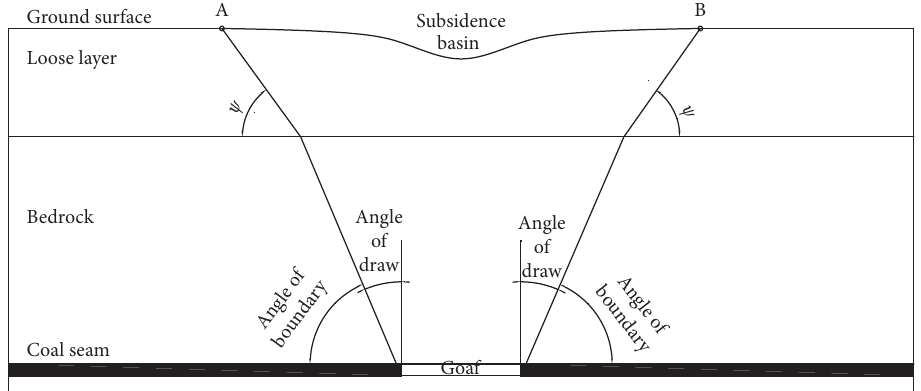
Figure 1: Definition of the inner boundary of overburden rock.